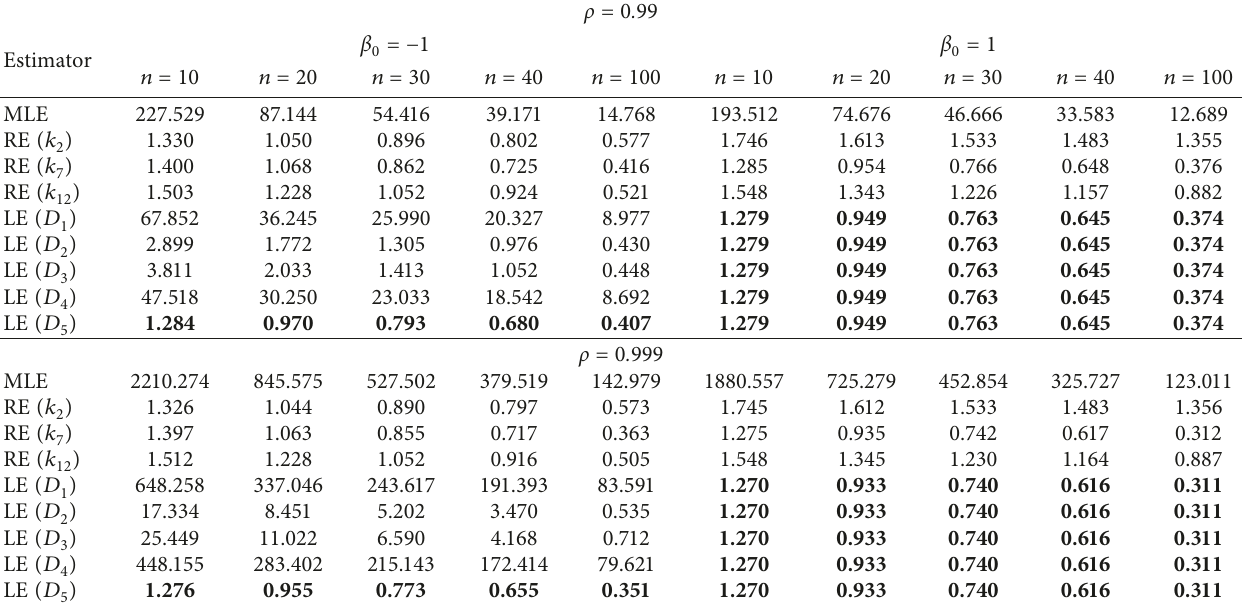
Table 6: Estimated SMSE values for different n, ρ ,k, d, and β